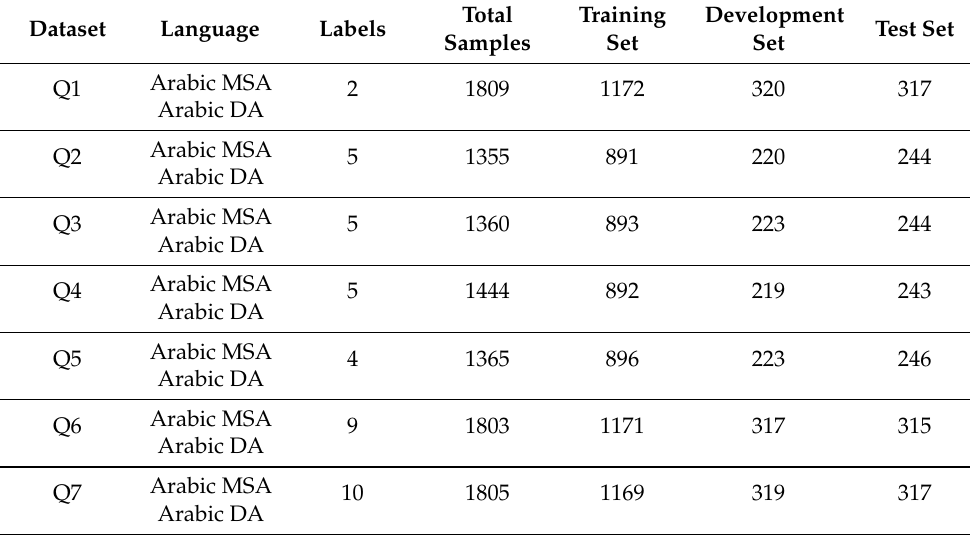
Table 3. Descriptions and statistics for the tested